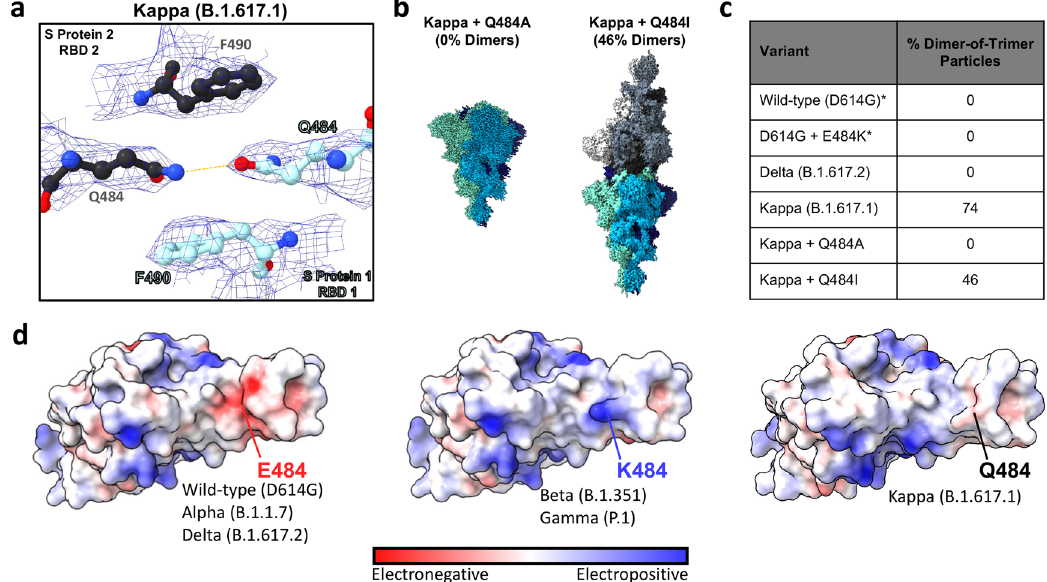
Fig. 5 Impact of residue identity at position 484 on S protein oligomerization. a Detailed view of the Kappa (B.1.617.1) dimer-of-trimers cryo-EM density map and fi tted model at the Q484-Q484 interaction site. The hydrogen bond formed between Q484 residues located in different S ectodomain trimers (S protein 2 RBD 2 in black, and S protein 1 RBD 1 in cyan) is indicated with a yellow dashed line. b Cryo-EM density maps for the Kappa + Q484A and Kappa + Q484I mutated S proteins. c Summary table of the proportion of dimerised particles in S proteins harbouring mutations at position 484. Asterisks indicate structures reported in previous publications 23 . d E484, K484, and Q484 RBD electrostatic surface potentials highlighting the surface potentials at position 484. The E484 surface potential was generated using the previously reported wild-type (D614G) + ACE2 focus-re fi ned atomic model 23 . The K484 surface potential was generated using the previously reported D614G + N501Y + E484K focus-re fi ned atomic model 23 . The Q484 surface potential was generated using the Kappa + ACE2 focus-re fi ned atomic model reported in the present